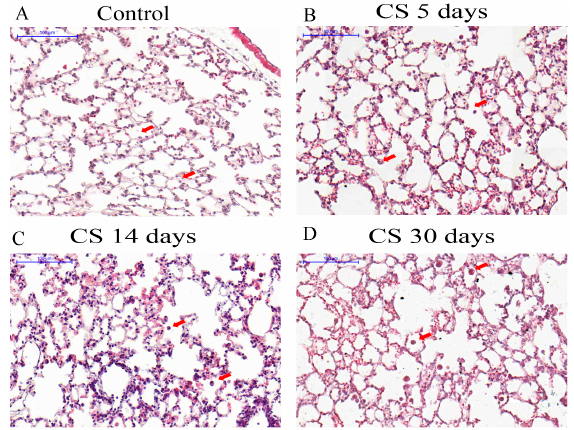
Figure 1. Photomicrographs of lung sections stained with hematoxylin and eosin. Bars are equal to 100 μ m. ( A ) Control group (air exposed); ( B ) Mice exposed to cigarette smoke (CS) for 5 days; ( C ) Mice exposed to CS for 14 days; ( D ) Mice exposed to CS for 30 days. Arrowheads represent leukocytes in alveoli.